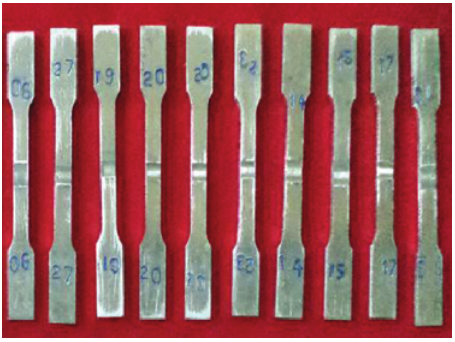
Figure 5: Photograph of fabricated tensile specimen (before